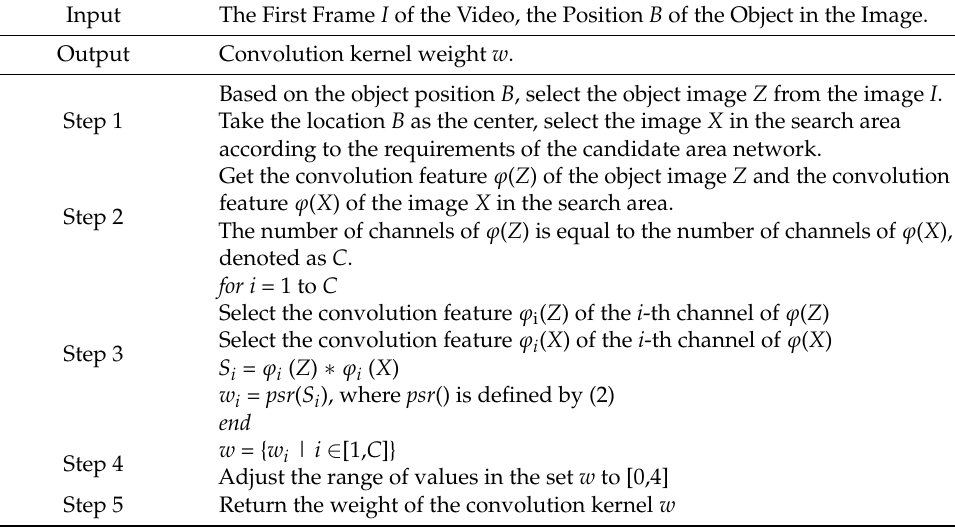
Table 1. The proposed object-aware convolution kernel attention mechanism